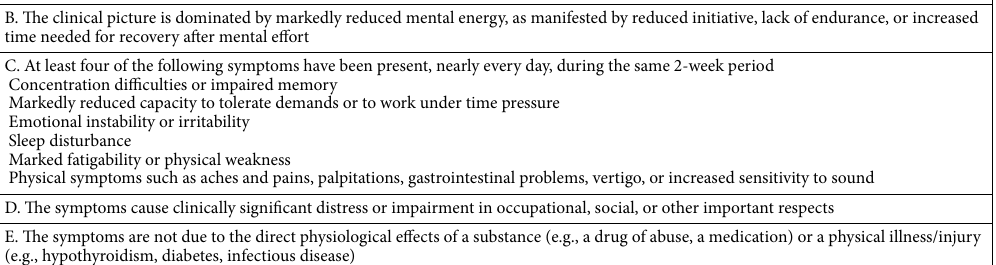
Table 1. Diagnostic criteria for stress-induced exhaustion disorder (SED) according to the Swedish National Board of Health and Welfare. Criteria A–E must be fulfilled to diagnose